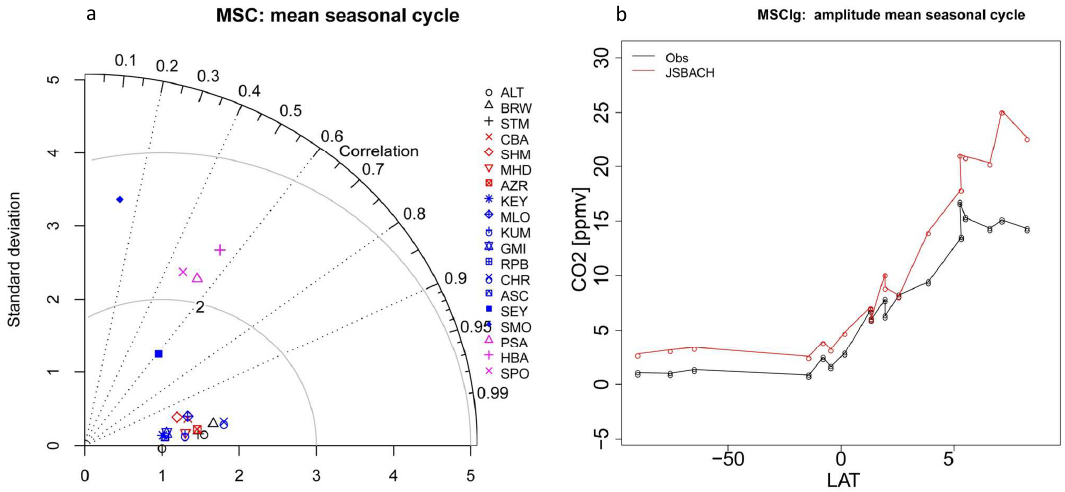
Fig. 3. (a) Taylor diagram of the mean seasonal cycle of JSBACH. (b) Latitudinal gradient of the amplitude of the mean seasonal cycle. The x-axis of the Taylor diagram indicates a mismatch in terms of amplitude and the y-axis provides information in term of phase correspondence. Stations in the coloured list are sorted according to latitude: black, 90 ◦ N–60 ◦ N; red, 60 ◦ N–30 ◦ N; blue, 30 ◦ N–30 ◦ S; pink, 30 ◦ S–90 ◦ S.